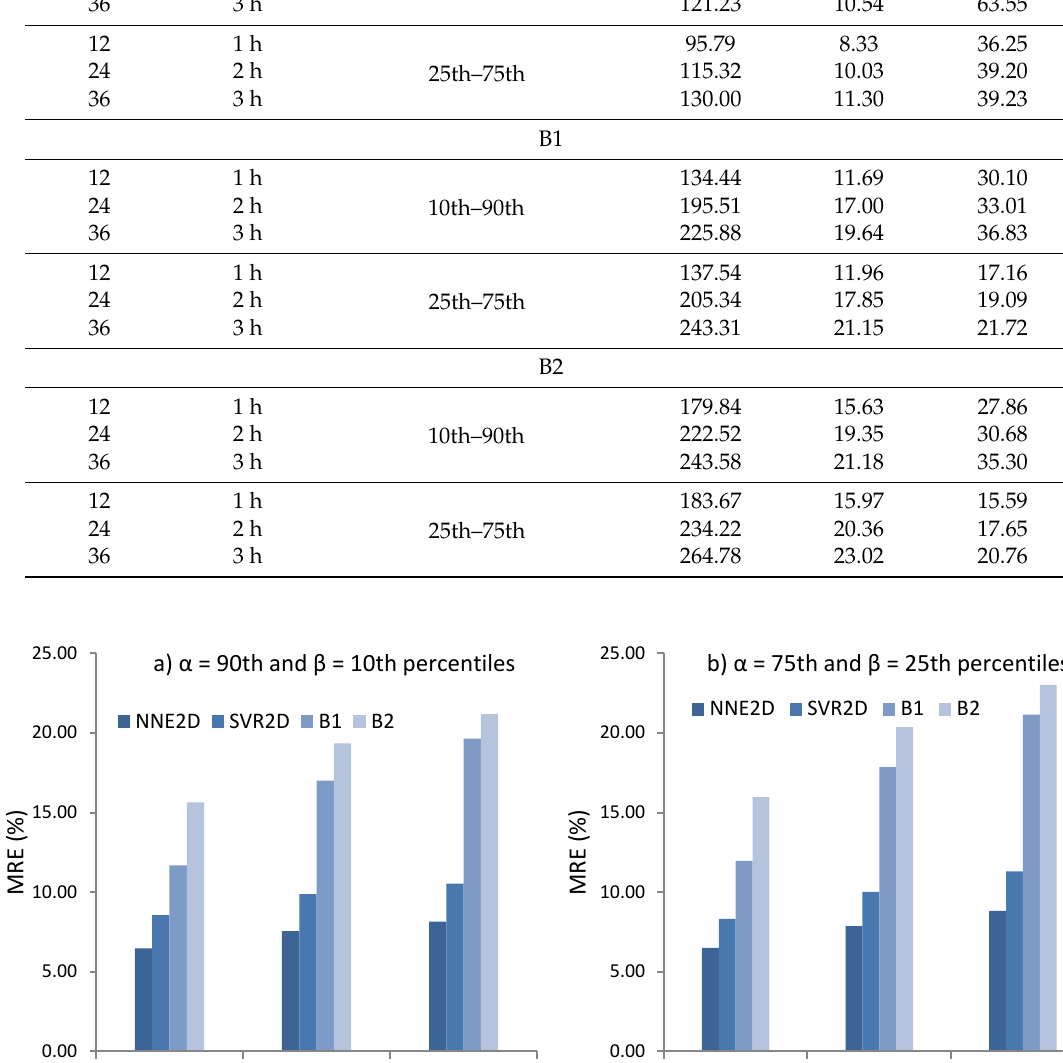
Table 4. Accuracy results for NNE2D.